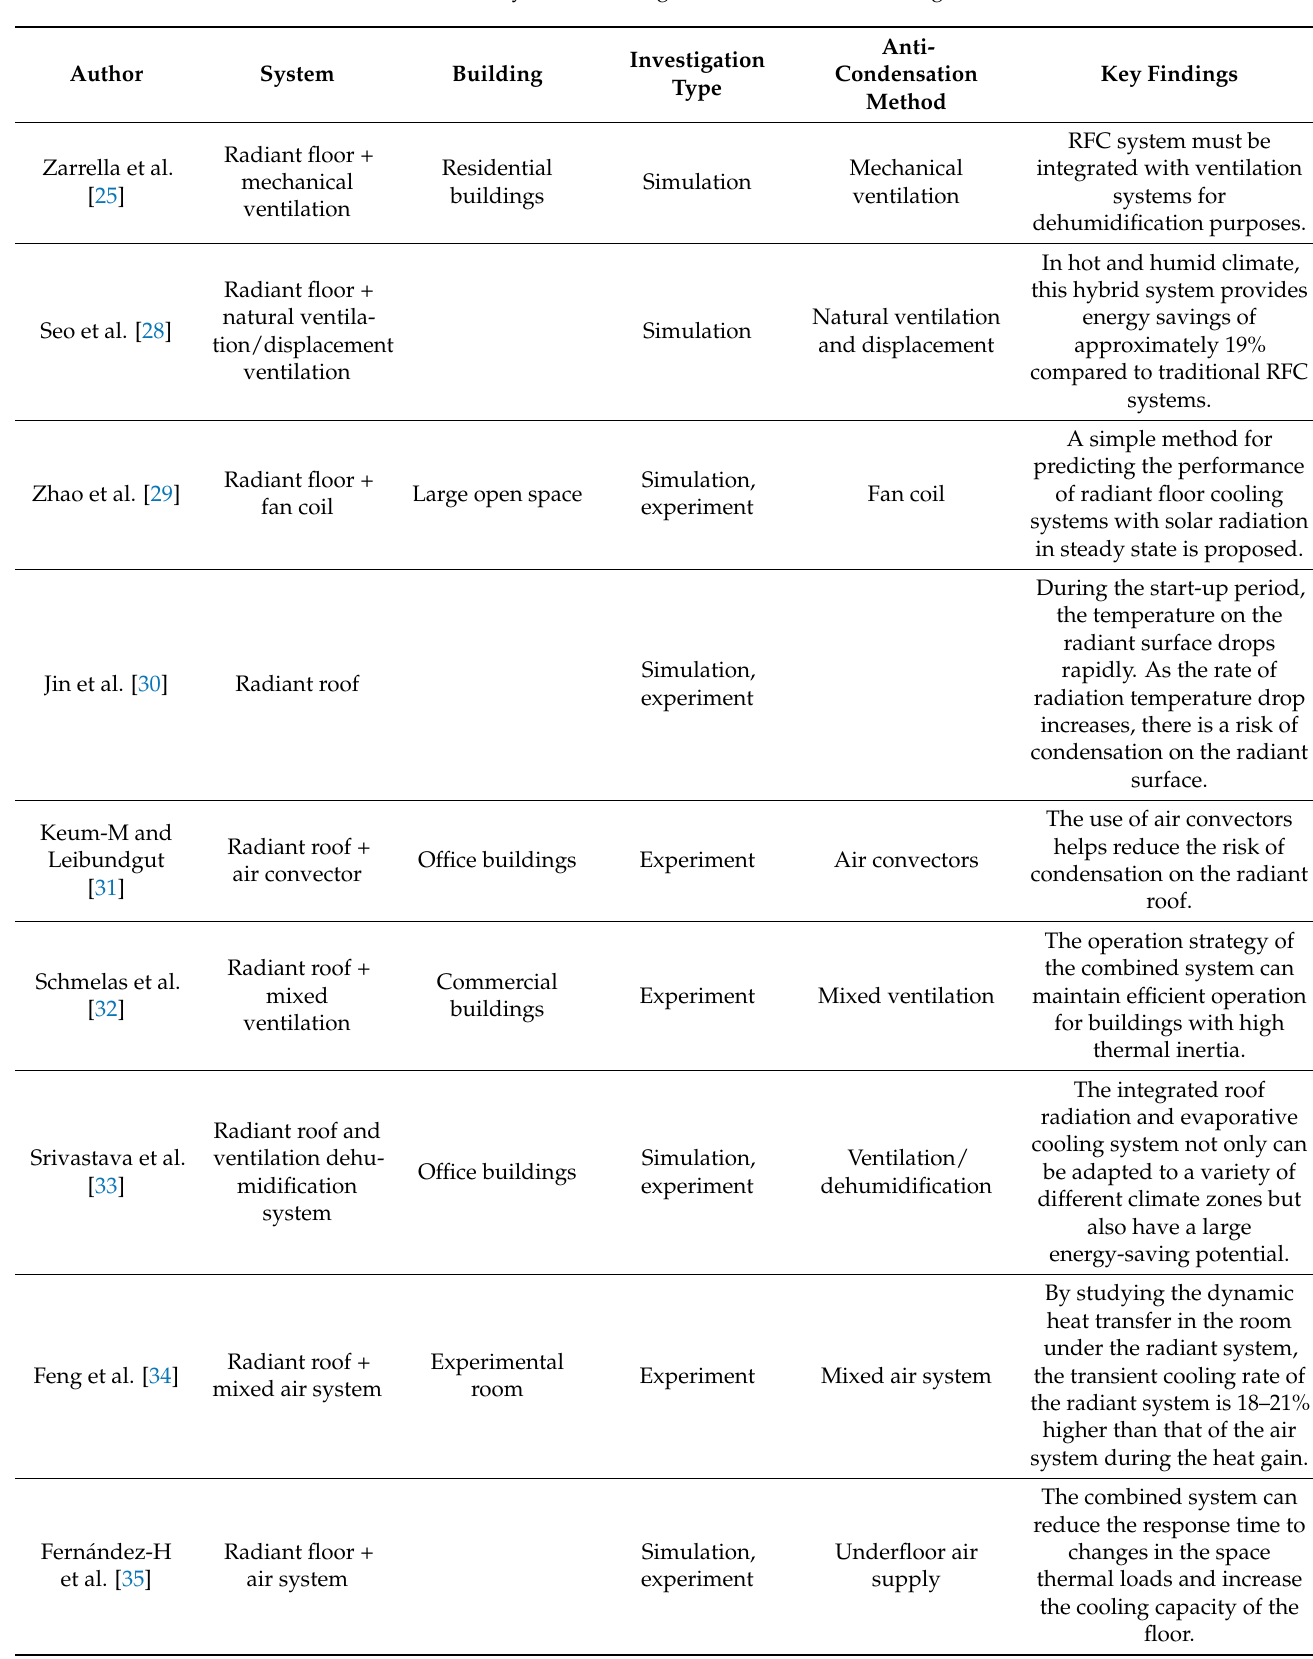
Table 1. Summary of the existing research on radiant